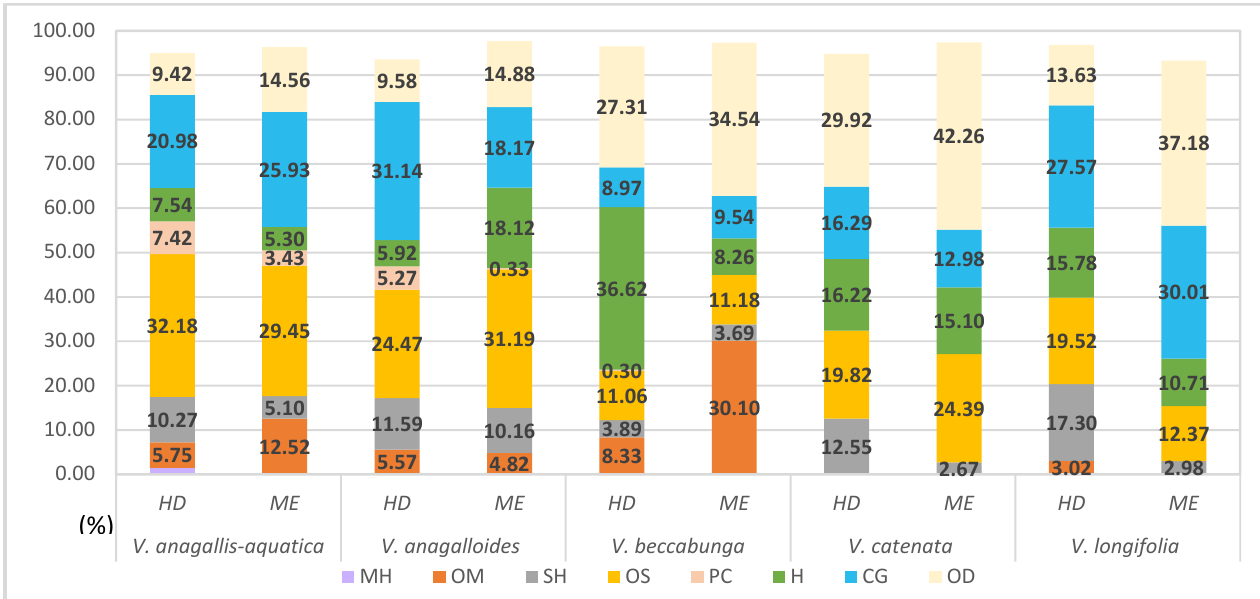
Figure 4. Relative content of volatile compounds in Veronica taxa collected from wet habitats. MH, monoterpene hydrocarbons; OM, oxygenated monoterpenes; SH, sesquiterpene hydrocarbons; OS, oxygenated sesquiterpenes; PC, phenolic compounds; H, hydrocarbons; CG, common group of acids, alcohols, and esters; OD, oxygenated diterpenes.